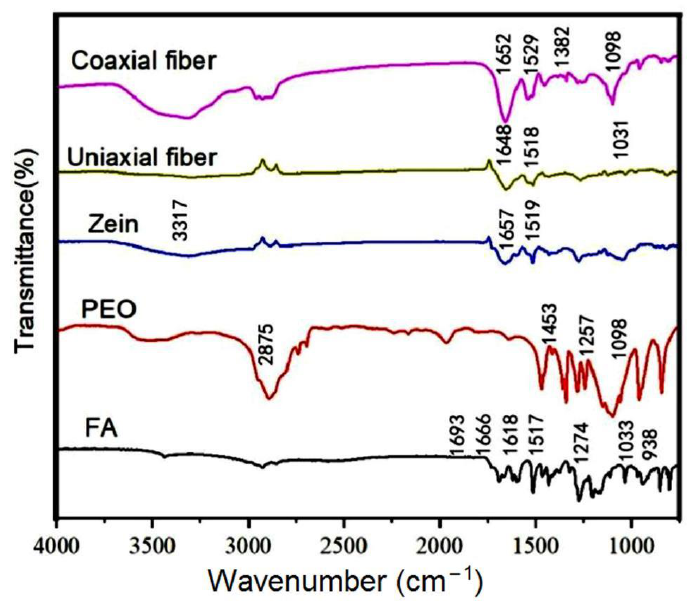
Figure 6. FT-IR spectra of raw materials and electrospinning fibers.